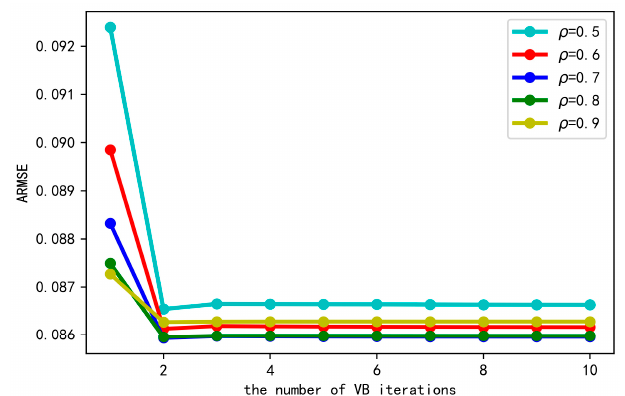
Figure 8. Tracking error of the proposed algorithm under different numbers of variational Bayesian (VB) iterations.